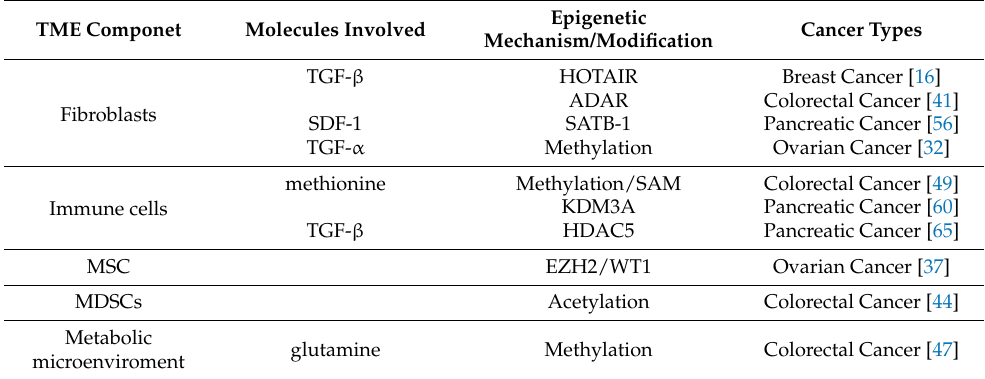
Table 1. Examples of the molecules involved in epigenetic mediated tumour–stroma